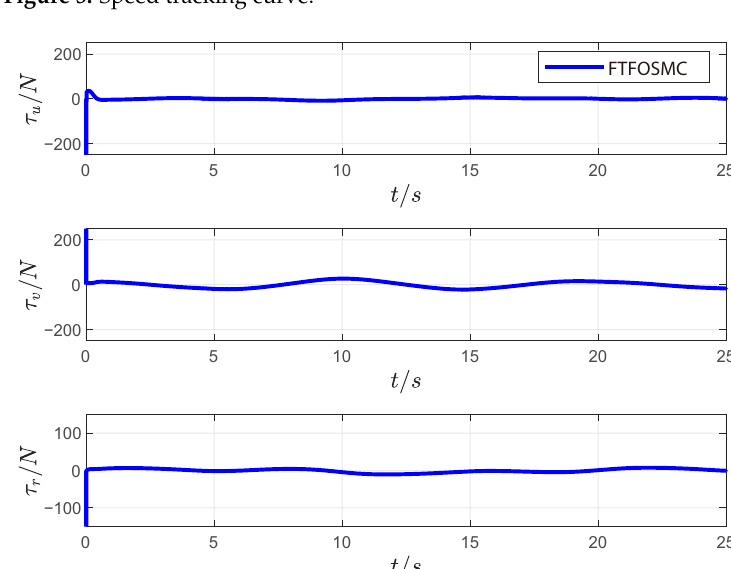
Figure 6. Control input